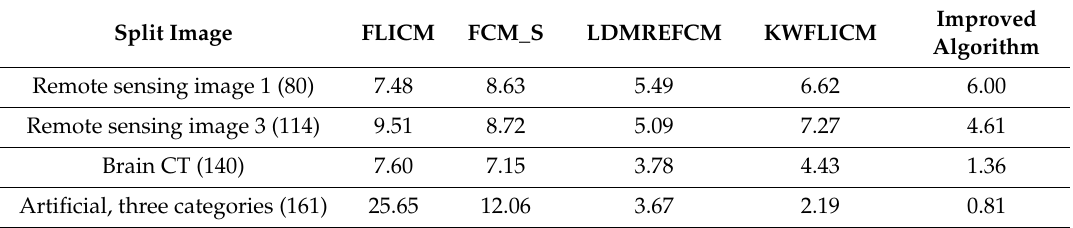
Table 8. Comparison of the MCR (%) for multiplicative noise resistance of